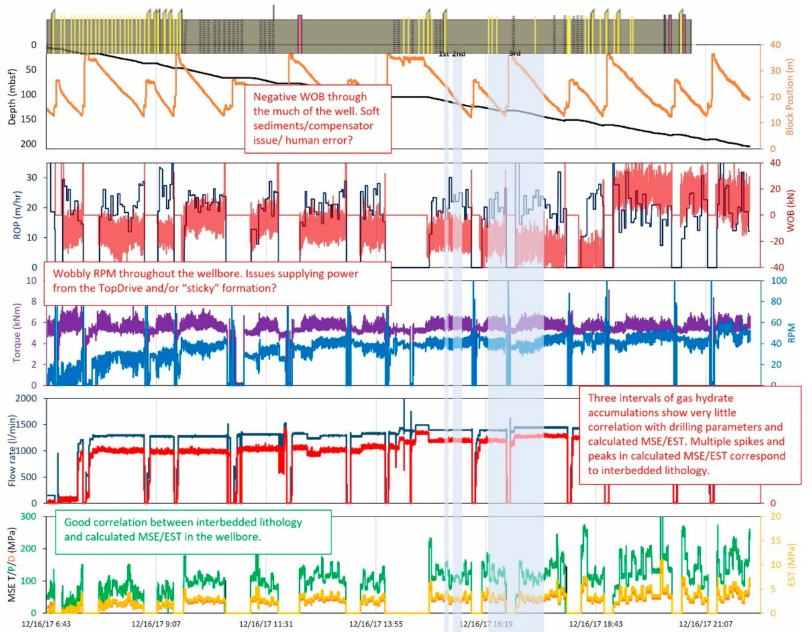
Figure 11. Time-based series for wellbore U1517A correlated with lithology column. Shaded areas present the three gas hydrate intervals detected in the wellbore by MWD/LWD logging